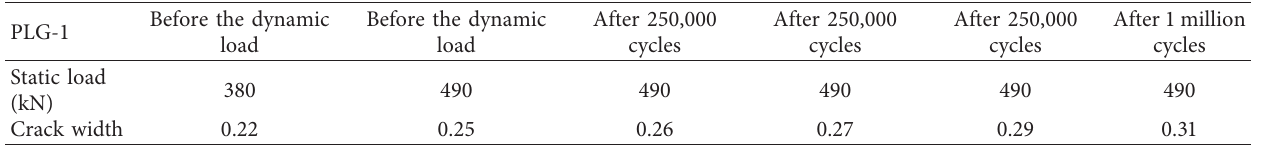
Figure 15: Failure mode of PLG-2. (a) Global failure of composite beam. (b) Crack of concrete slab. (c) Failure of concrete slab. Table 4: Cracks of concrete slab of PLG-1 (unit: